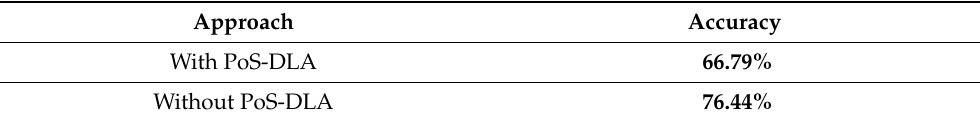
Table 6. Accuracy obtained by proposed Urdu